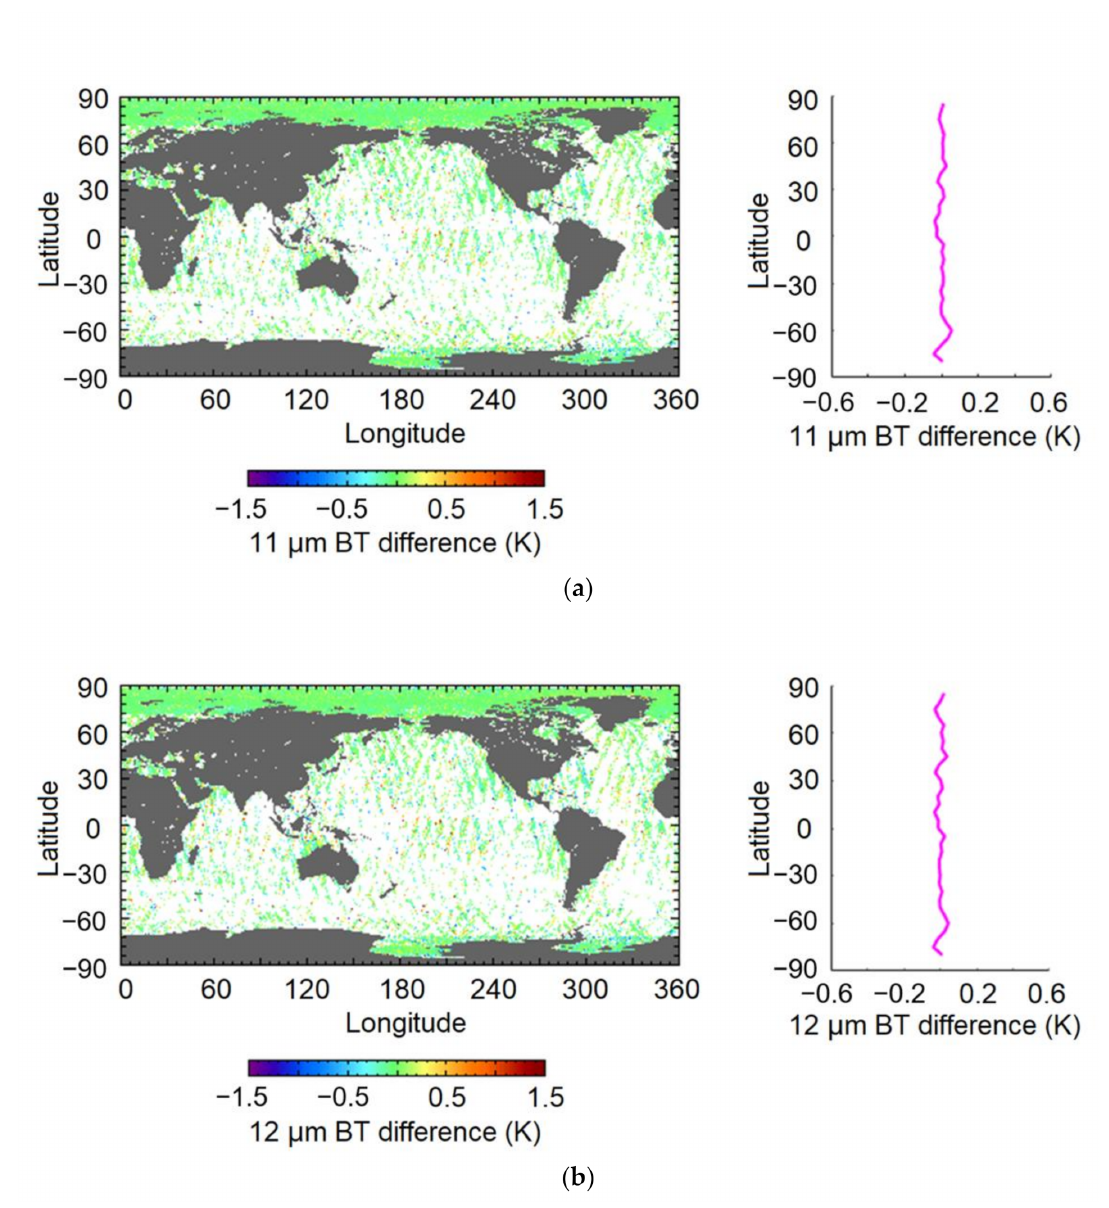
Figure 12. The geophysical distribution of the COCTS-corrected BT minus IASI BT differences for the ( a ) 11 and ( b ) 12 µ m channel. The color in the left panels indicates the COCTS-corrected BT minus IASI BT differences in the collocations. The purple lines on the right panels are the variations in mean values of the BT differences in every 10 ◦ latitude